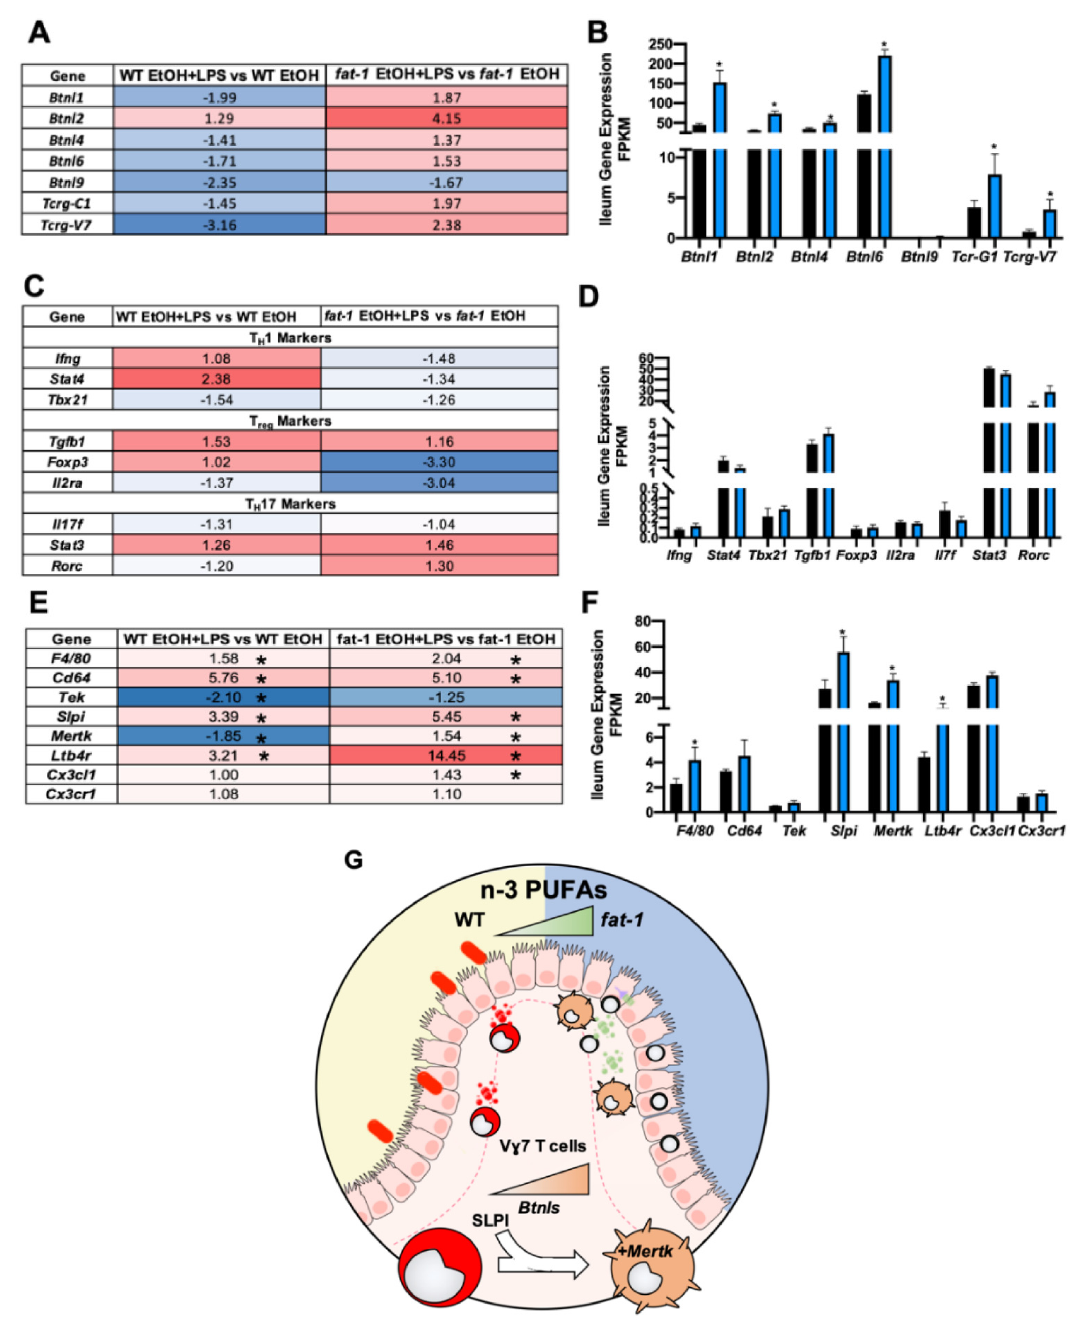
Figure 6. Increased n-3 PUFAs enhanced the ileum expression of Btnl-mediated T cell and pro-restorative macrophage gene signatures. ( A ) Heatmap fold change values for ileum Btnl and γδ T cell gene signatures for the WT EtOH + LPS vs. WT EtOH comparison and the fat-1 EtOH + LPS vs. fat-1 EtOH comparison. ( B ) Ileum Btnl and γδ T cell gene signature expression for WT EtOH + LPS and fat-1 EtOH + LPS-treated mice. ( C ) Heatmap fold-change values for T h 1, T reg , and T h 17 cell gene markers for the WT EtOH + LPS vs. WT EtOH comparison and the fat-1 EtOH + LPS vs. fat-1 EtOH comparison. ( D ) Gene expression of T h 1, T reg , and T h 17cell gene markers in WT EtOH + LPS vs. fat-1 EtOH + LPS-treated mice. ( E ) Heatmap fold change values for ileum pro-restorative macrophage markers. ( F ) Pro-restorative macrophage gene expression for WT EtOH + LPS and fat-1 EtOH + LPS-treated mice. ( G ) Graphical representation of BTNLs, γδ T cells, and pro-restorative macrophages being enhanced in the ileum by n-3 PUFA enrichment. Statistical significance ( p < 0.05) is denoted by an *.